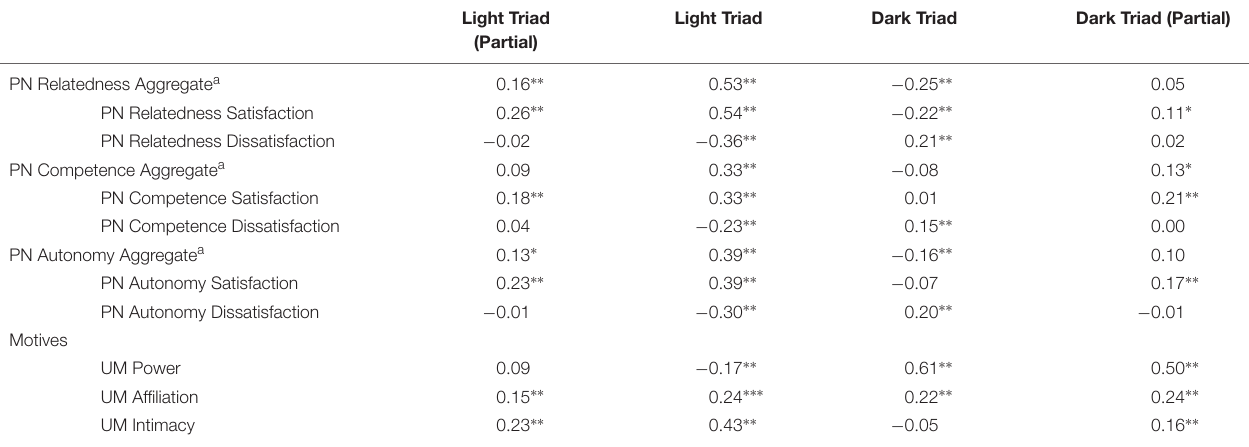
TABLE 7 | Correlations and partial correlations between psychological needs/motives and light vs. dark triad. Light Triad Light Triad Dark Triad Dark Triad (Partial) (Partial) PN Relatedness Aggregate a 0 . 16 ∗∗ 0 . 53